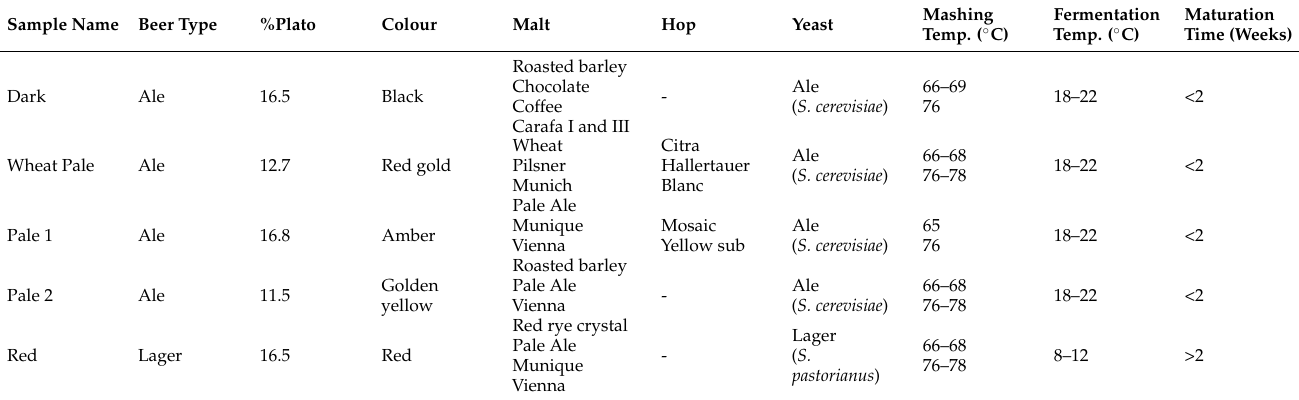
Table 1. Information on the craft beer samples analyzed in this work